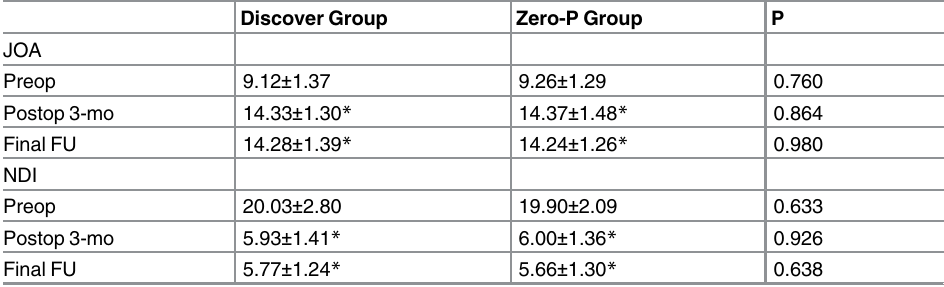
Table 2. Comparison of clinical outcomes between the 2 groups.